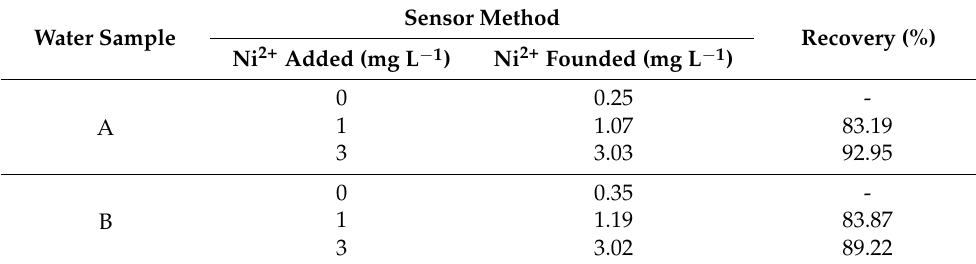
Table 2. Determination of Ni 2+ in seawater sample.